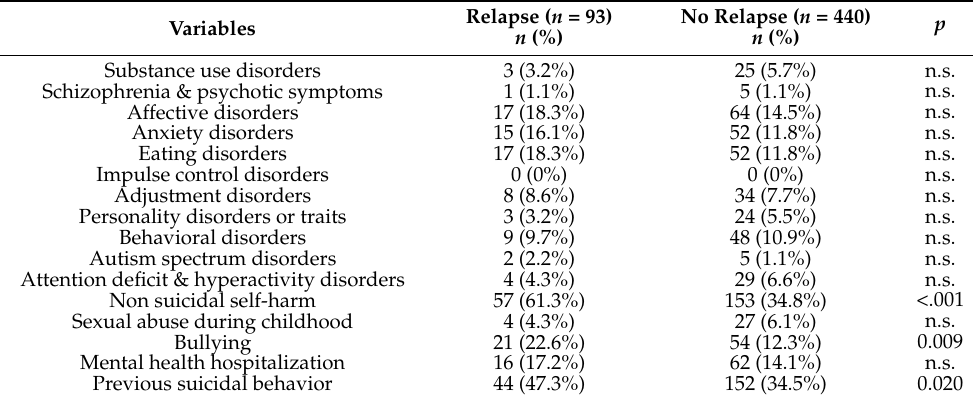
Table 3. Clinical background of the